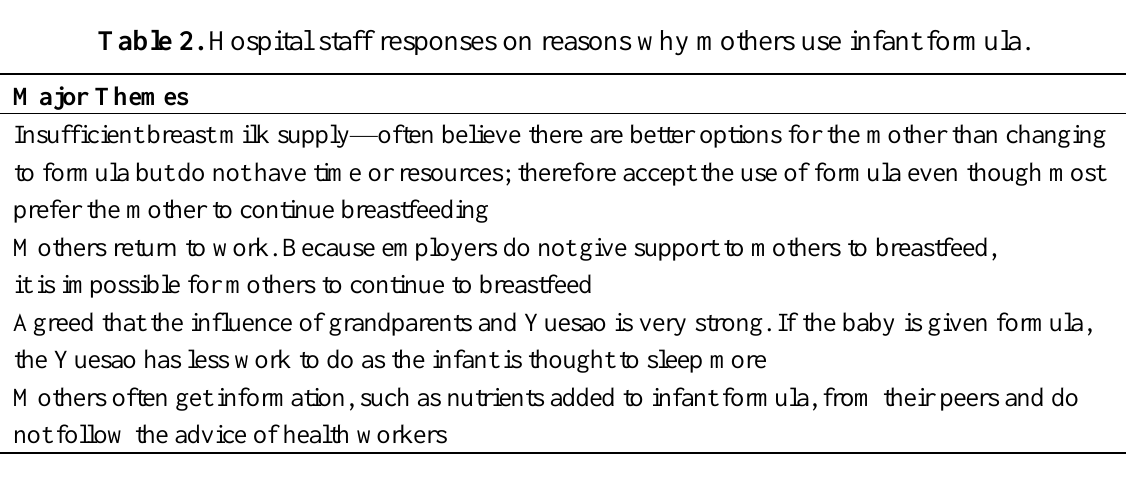
Table 2. Hospital staff responses on reasons why mothers use infant